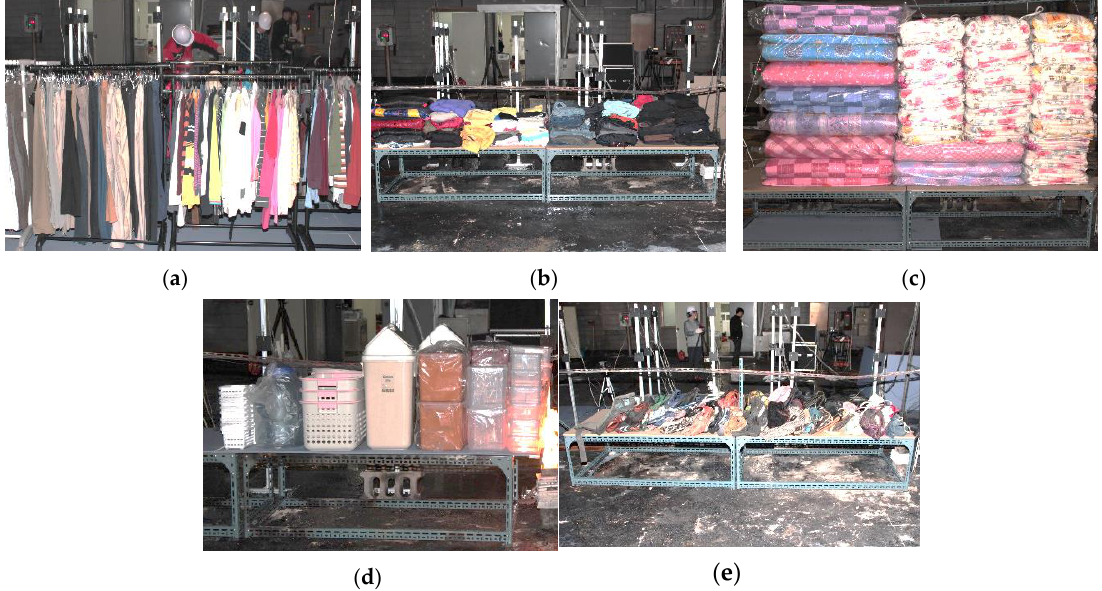
Figure 3. Photographs of the major combustibles arranged to conduct real-scale fire experiments: ( a ) Clothing hanging on the hangers; ( b ) clothing placed on the stalls; ( c ) blankets placed on the stalls; ( d ) plastics placed on the stall; ( e ) bags placed on the stalls.